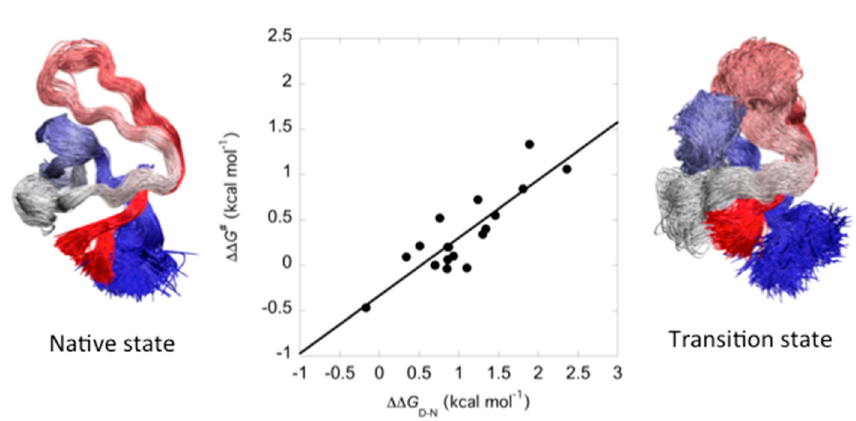
Figure 3. Linear Free Energy Relationship (LFER) plot in protein folding. The data refer to the Φ value analysis of the SH3 domain from Grb2 (81). The structure of the native state, obtained by NMR, and the transition state, calculated by using restrained molecular dynamic simulations, are reported on the left and on the right of the plot, respectively. As explained in the text, linearity in LFER plots is a hallmark of the nucleation-condensation mechanism and represents a common feature of globular proteins. By following this scenario, the transition state is a distorted version of the native state, as nicely exemplified by the data reported in the figure.